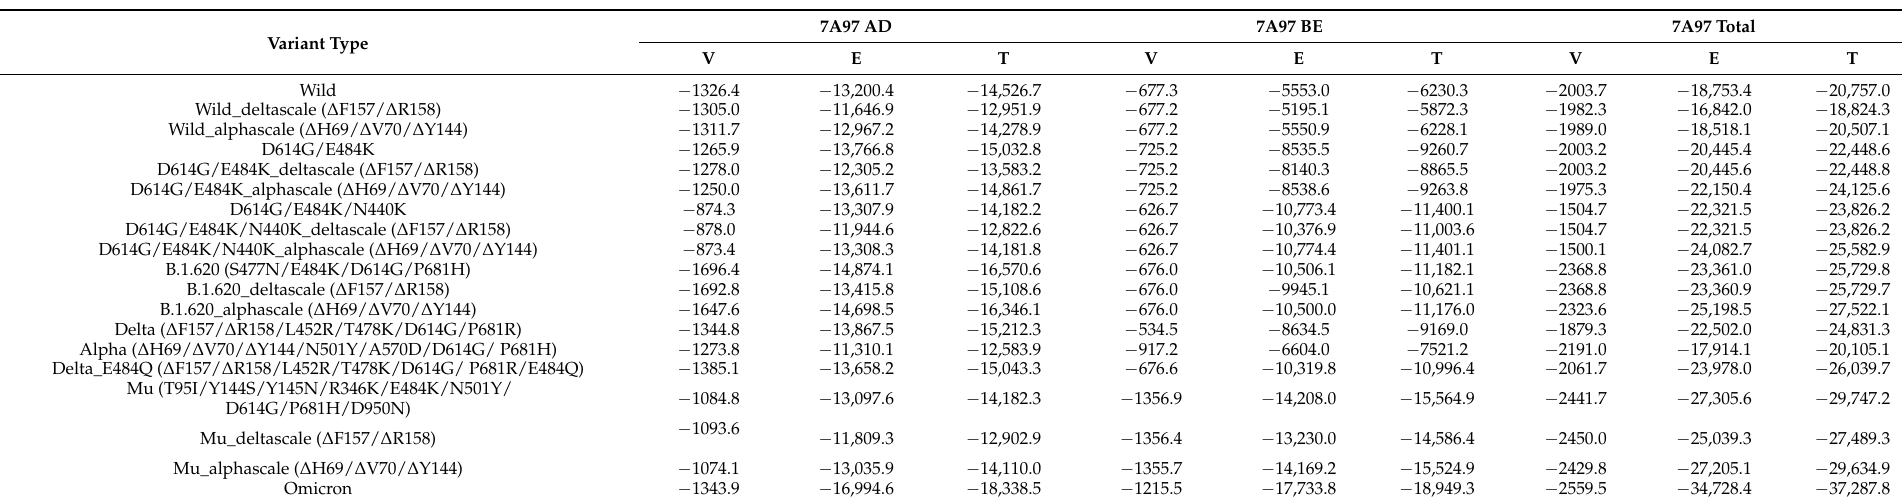
Table 3. Summary of the MM/PBSA between the S protein and ACE2 in the two-open-complex form. V indicates van der Waals energy, E denotes electrostatic energy, and T is the total energy (kJ/mol). The values were measured in the final trajectory (10 ns). Variant Type